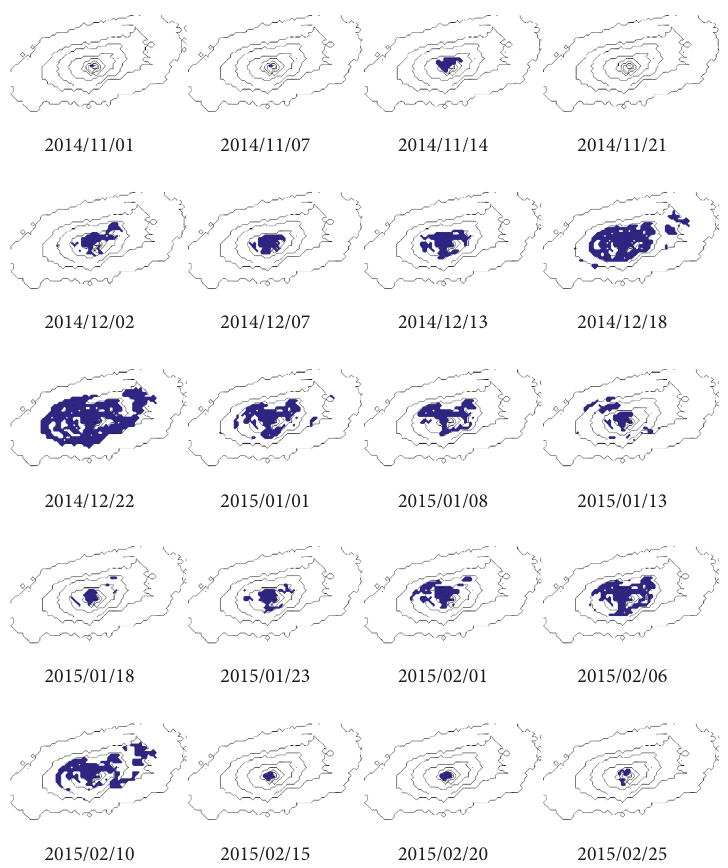
Figure 11: Change of the snow coverage over Jeju Island from November 1, 2014, to February 25, 2015, determined by applying the variable threshold